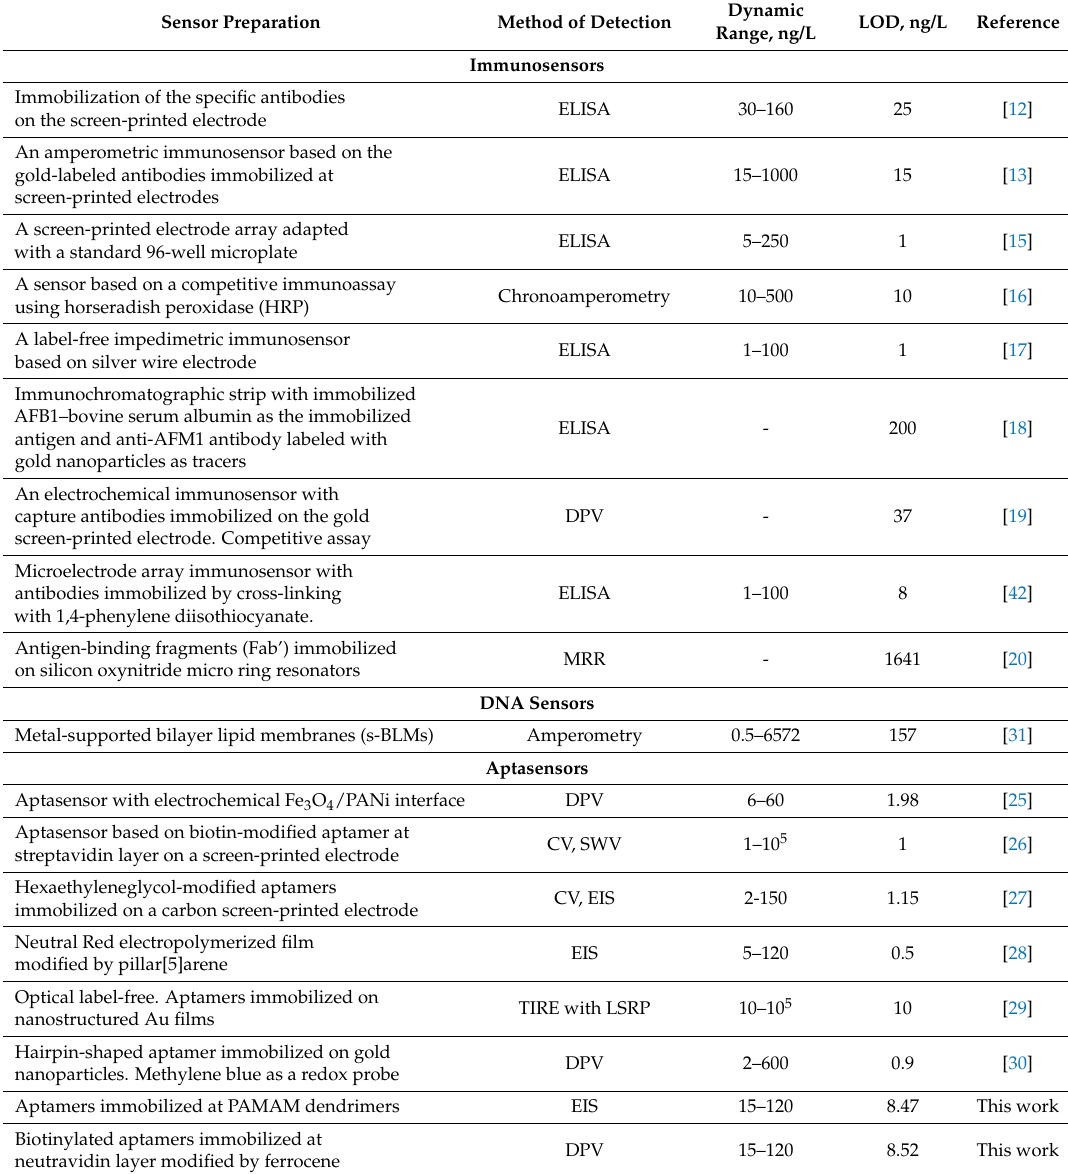
Table 1. Comparison of the LOD values of electrochemical aptasensors for AFM1